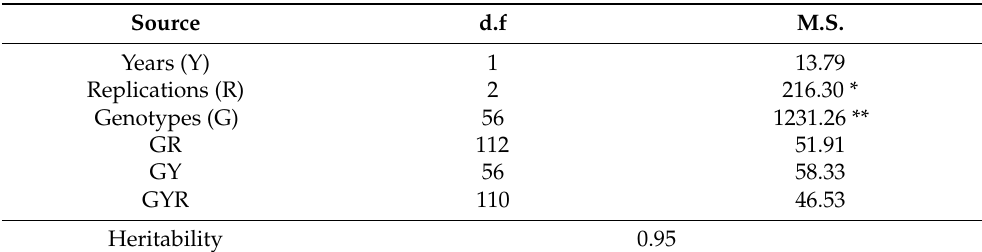
Table 1. Analysis of variance for loose smut resistance in the 60 genotypes comprising the Egyptian spring barley